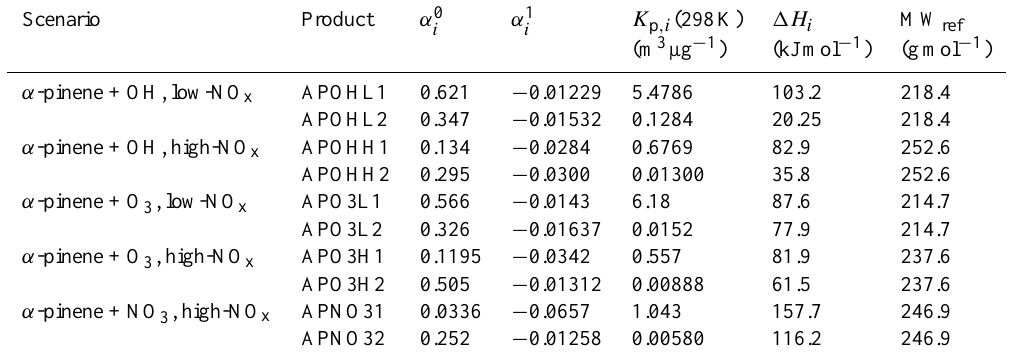
Table 4. Fitted parameters for the 10 condensable products in the temperature-dependent parameter model (5 scenarios considered). Scenario Product α 0